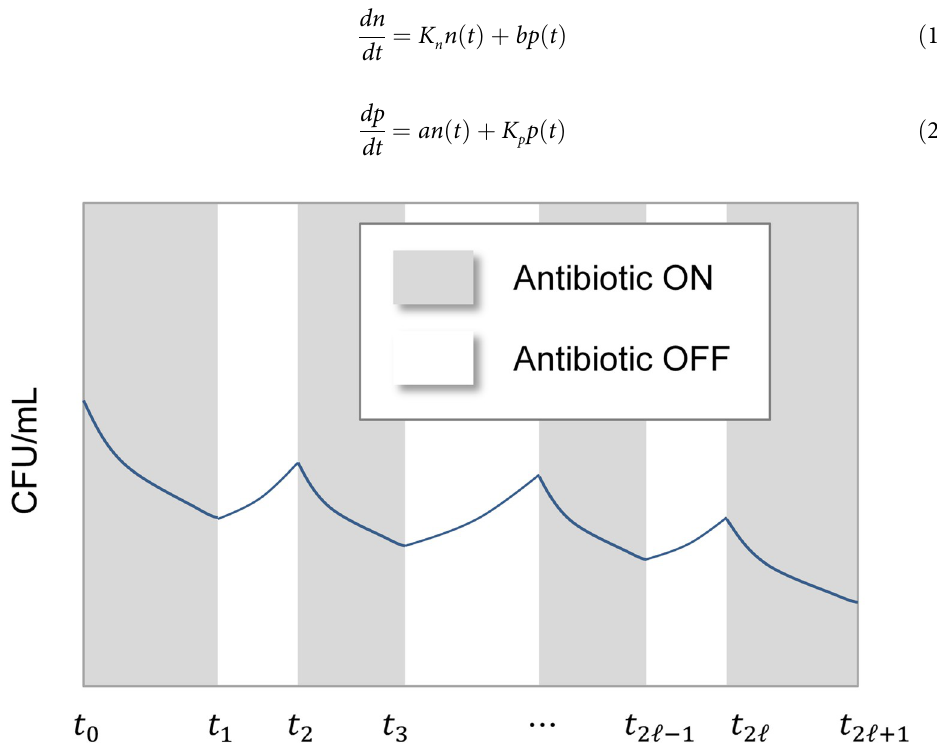
Fig 1. A schematic of the outcome of a pulse dosing regimen showing declining peaks and dips of a bacterial cell population over time.